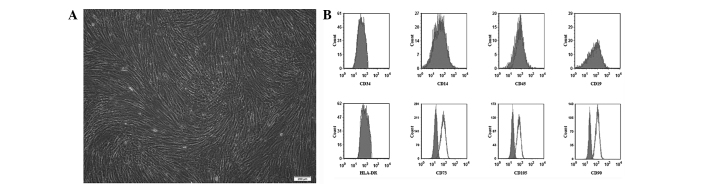
Morphological appearance and immunophenotypes of MSCs. (A) Primary human MSCs (magnification, ×100). (B) Positive and negative surface biomarkers on primary MSCs were analyzed by FACSCalibur. The black curves present tested cells and the shadow areas present isotype controls. MSCs, mesenchymal stem cells; FACS, fluorescence-activated cell sorting.